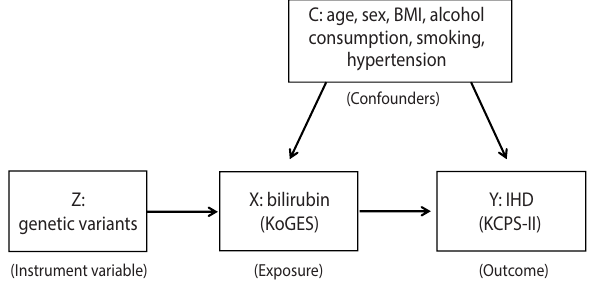
Table 2. MR for the effects of serum bilirubin on ischemic heart dis- ease risk